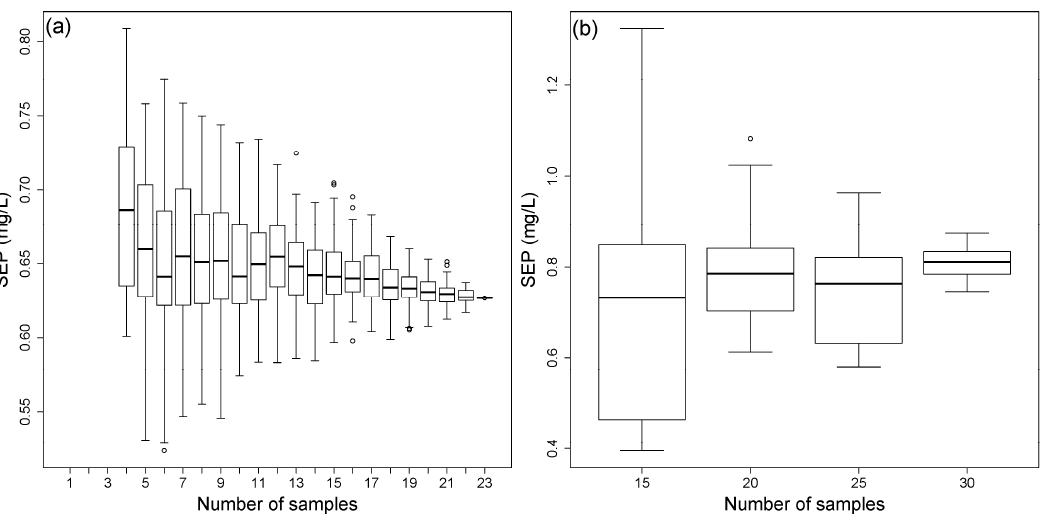
Figure 10. Lignin SEP vs. number of calibration samples of ( a ) repeated calibration with randomly chosen calibration samples of block 3 applied to block 4 and ( b ) rdCV applied to block 4 with repeated variation and reduction of the training set samples.